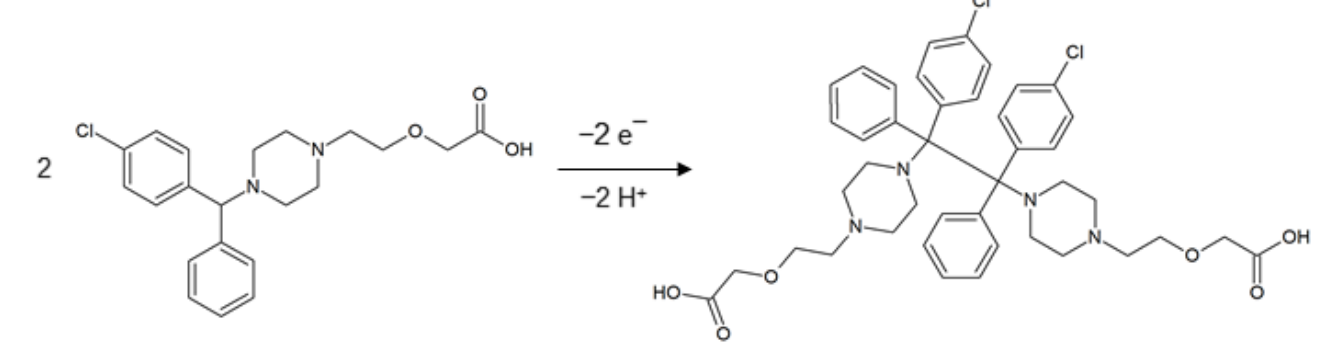
Figure 6. Proposed mechanism of CTZ electrode reaction [18].